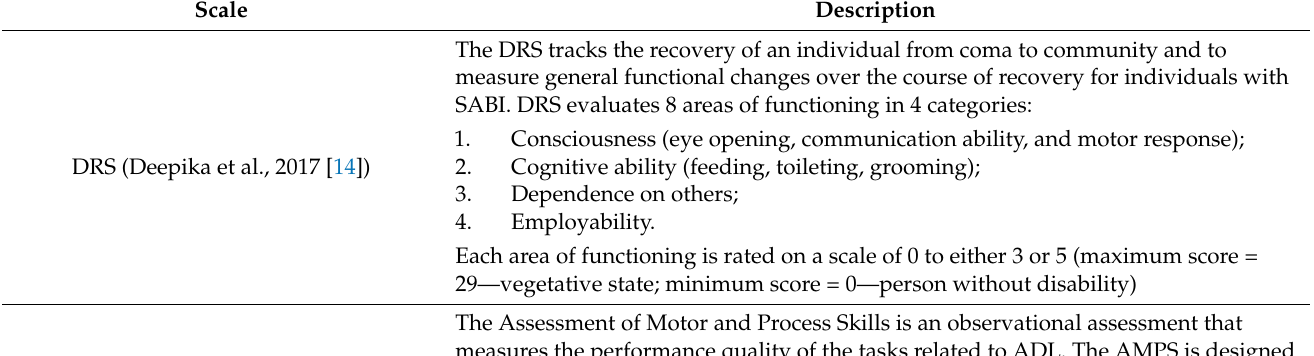
Table 5. Assessment global functioning scales to use in severe to moderate disability.